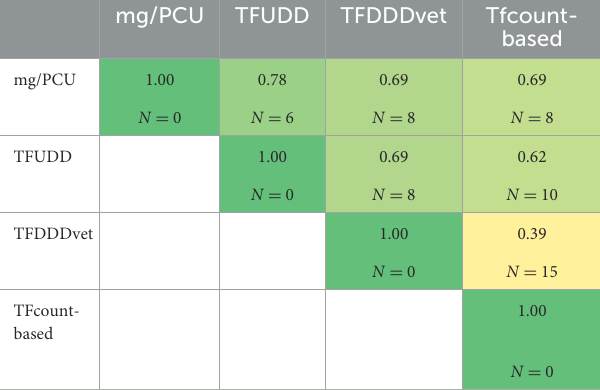
TABLE 3 Pairwise comparison of AMU indicators using spearman rank